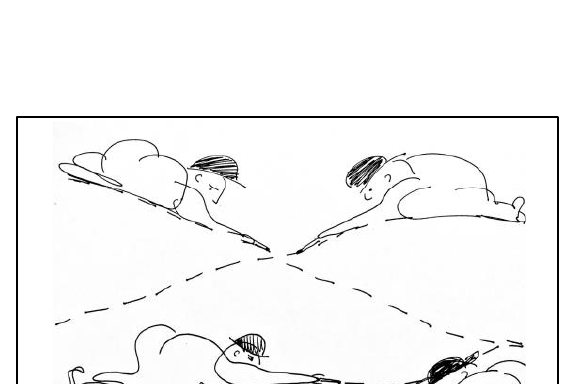
J. M. Design Studio, “Prototype #3 A Wall of Artists Redrawing Border Walls” from The Other Border Wall Proposals (2017). Digital scanned image of ink drawing on paper, text. 8 ½ X 11 inches. Collection of